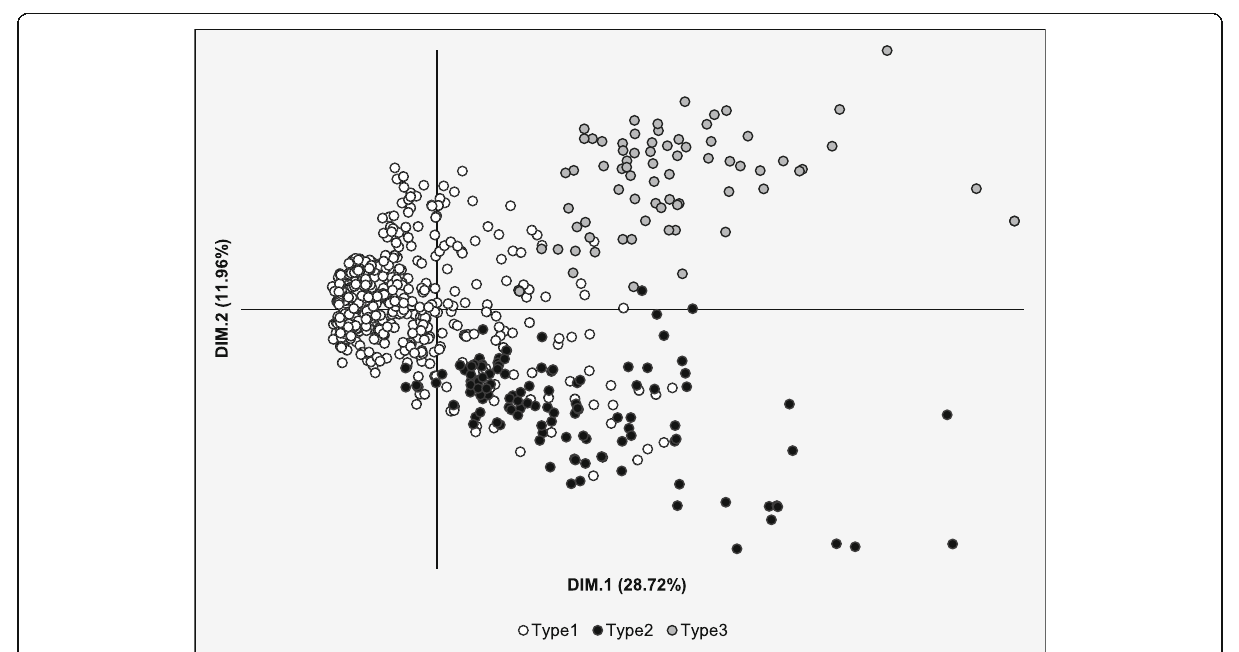
Fig. 6 Projection of cattle farms on the main plan (Dim.1 – Dim.2) according to their typology